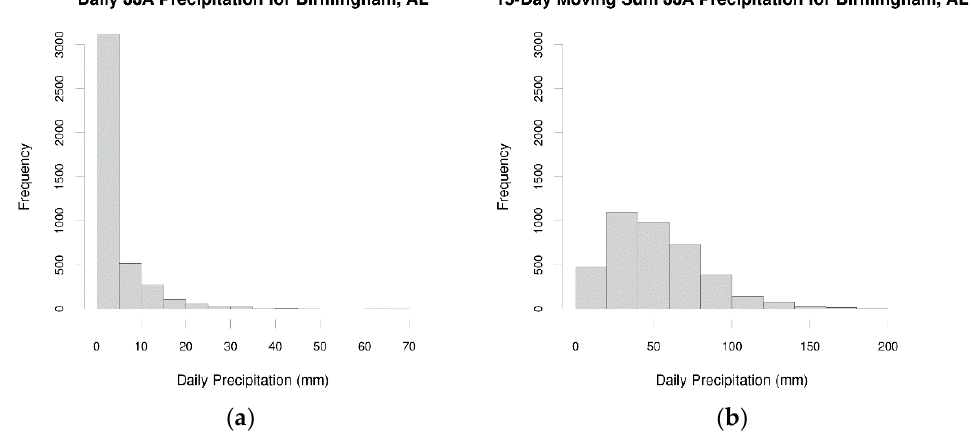
Figure 1. Daily precipitation (panel a ) for NARR grid point nearest Birmingham, AL (33.24277° N, 86.79012° W) and 15-day moving sum of precipitation for the same grid point (panel b ). Note the near elimination of the impacts of zeroes when employing the moving sum.